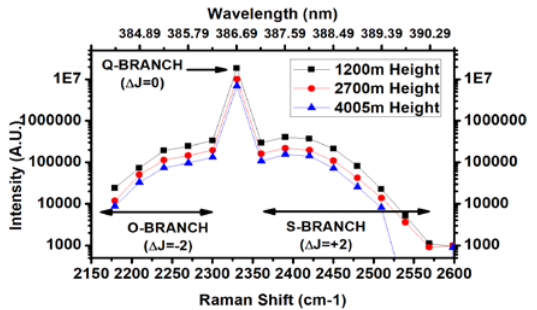
Figure 1. Example of a LITES measurement (elastic signals) at 532 nm taken on 7 March 2018.